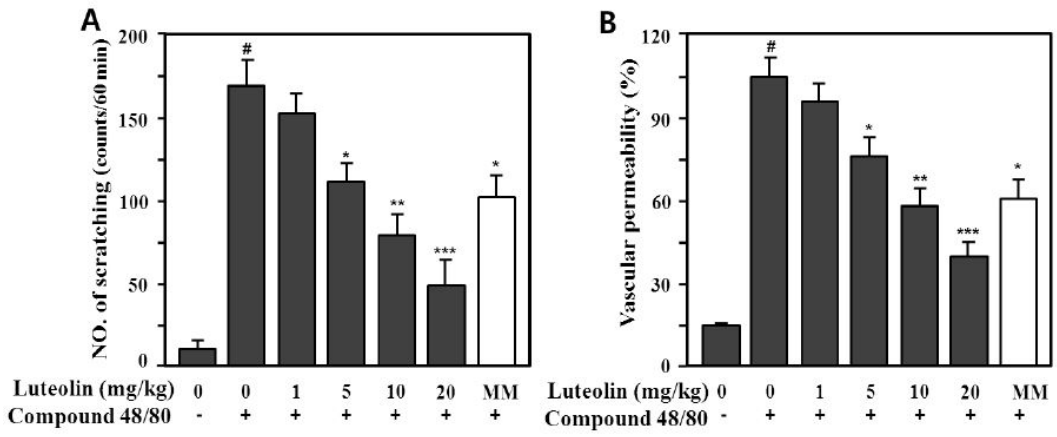
Figure 5. Effect of luteolin on compound 48/80-induced scratching behavior ( A ) and vascular permeability ( B ) in mice. Scratching behavior was counted for 60 min after intradermal injection of compound 48/80 (50 μ g/site). Luteolin (1–20 mg/kg) was orally administered 1 h before injection of compound 48/80. Values are means ± standard error (SE) ( n = 8). # p < 0.001 versus the non-treated control group; * p < 0.05, ** p < 0.05, *** p < 0.01 versus compound 48/80 alone group.